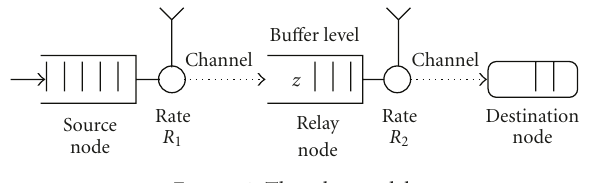
Figure 1: The relay